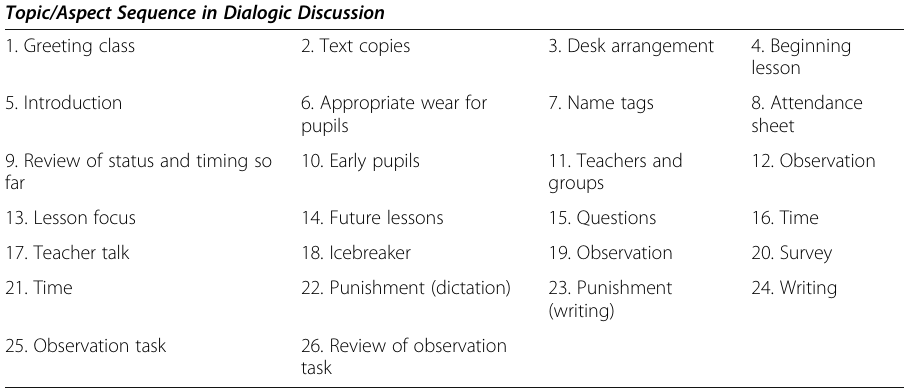
Table 2 Topic and sequence in student teachers ’ lesson-planning discussion Topic/Aspect Sequence in Dialogic